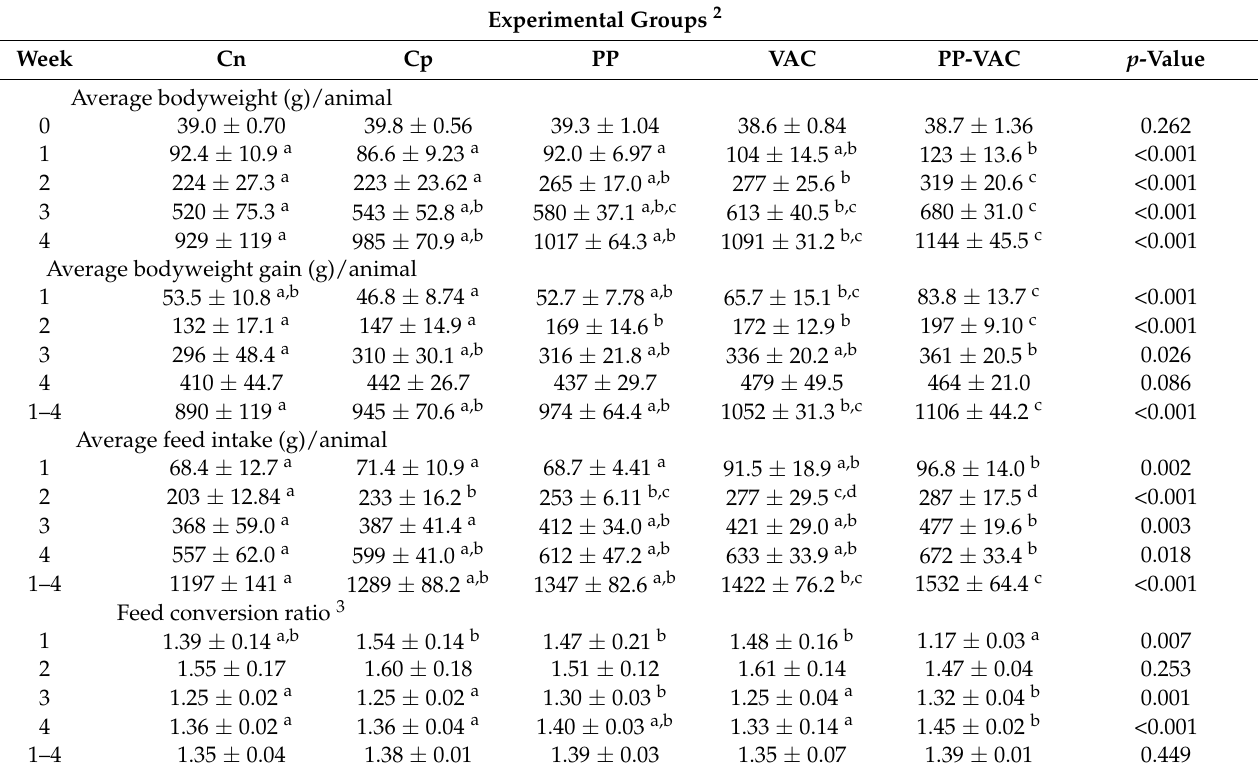
Table 1. Impact of parent stock vaccination and dietary pre-and probiotic combination on perfor- mance parameters 1 of growing Ross 308 broilers challenged with E. coli O1/O18 on day eight of life. Experimental Groups